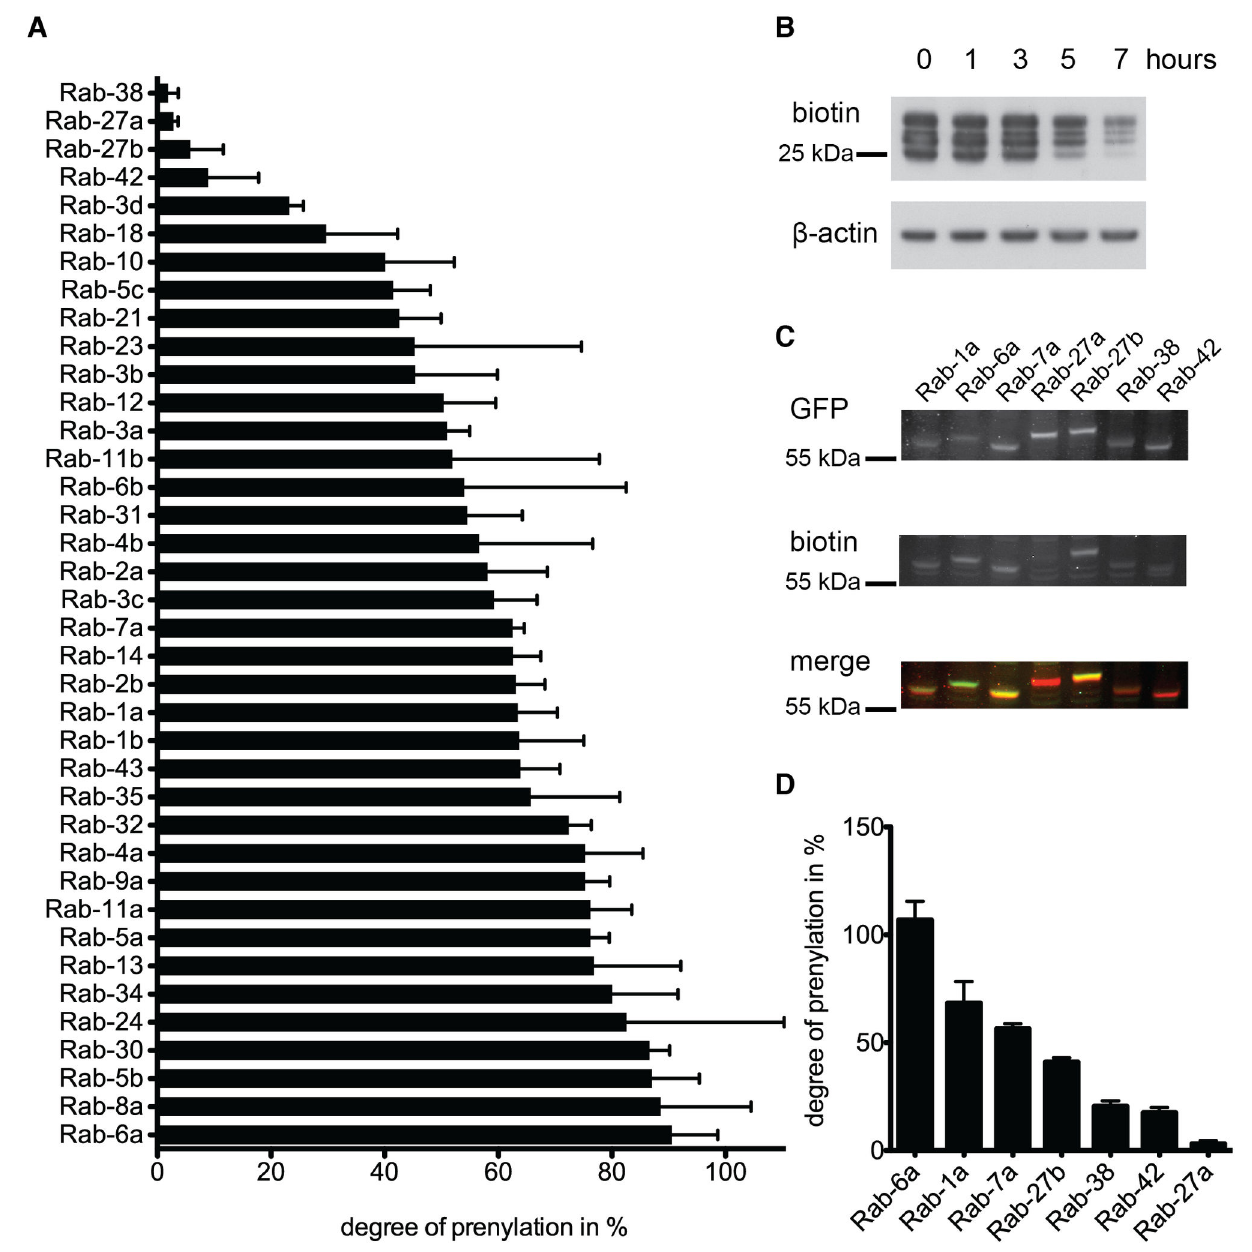
Figure 5. Analysis of Rab prenylation rates in vivo and in vitro . (A-B) Analysis of Rab prenylation status after blocking and releasing prenylation in vivo . HeLa cells were treated with compactin for 24h and then incubated with GGOH for different time periods. Cells were lysed and subjected to in vitro prenylation with BGPP and recombinant RabGGTase and REP for 6h. (A) Degree of prenylation for each Rab was determined by mass spectrometry. The decrease in signal from the timepoint 0h to 5h was determined by label-free spectral counting and converted into the degree of prenylation for each Rab 5 hours after GGOH addition. The graph represents the mean of three independent experiments (±SEM). (B) Streptavidin-HRP Western blot detection of unprenylated Rabs in the cellular lysates at different timepoints after GGOH addition to compactin-treated cells. The cellular lysates were prenylated with BGPP and RabGGTase as in Figure 3 (C) In vitro prenylation of lysate from compactin-treated HeLa cells transfected with different GFP-Rabs. In vitro prenylation reaction was stopped after an hour and subjected to Western blot analysis visualized by infrared Odyssey scanning for total GFP-Rab (GFP/red) and for prenylated biotin-labeled GFP-Rab (biotin/green). Representative blots are shown. (D) The graph represents the percentage of prenylated GFP-Rabs after an hour in vitro prenylation reaction normalized to complete (overnight) prenylation. Means of three independent experiments are shown (±SEM).